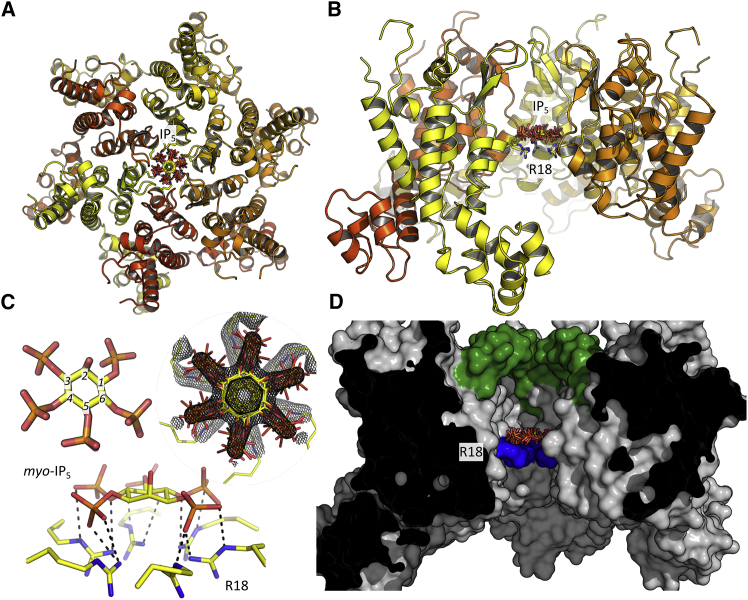
Structure of the HIV-1 Capsid Hexamer:IP5 Complex(A and B) Secondary structure representation of the complex shown from above (outside-facing, A) and side (within the capsid lattice, B). The six equivalent binding positions for IP5 are shown, together with the location of the R18 ring.(C) The structure of IP5 alone and interacting with the six arginine residues at position 18. Electron density (2Fo − Fc) centered around the ligand is shown as a mesh contoured at 1.4σ. Putative hydrogen bond interactions between IP5 and R18 side chains are shown as black dashes.(D) Molecular surface of the capsid hexamer sliced through the middle to reveal the internal cavity where IP5 is bound. All surface residues are colored gray except R18 (blue), and the β-hairpin (residues 1–12) that forms one end of the cavity (green). IP5, positioned above the R18 ring, is also shown.